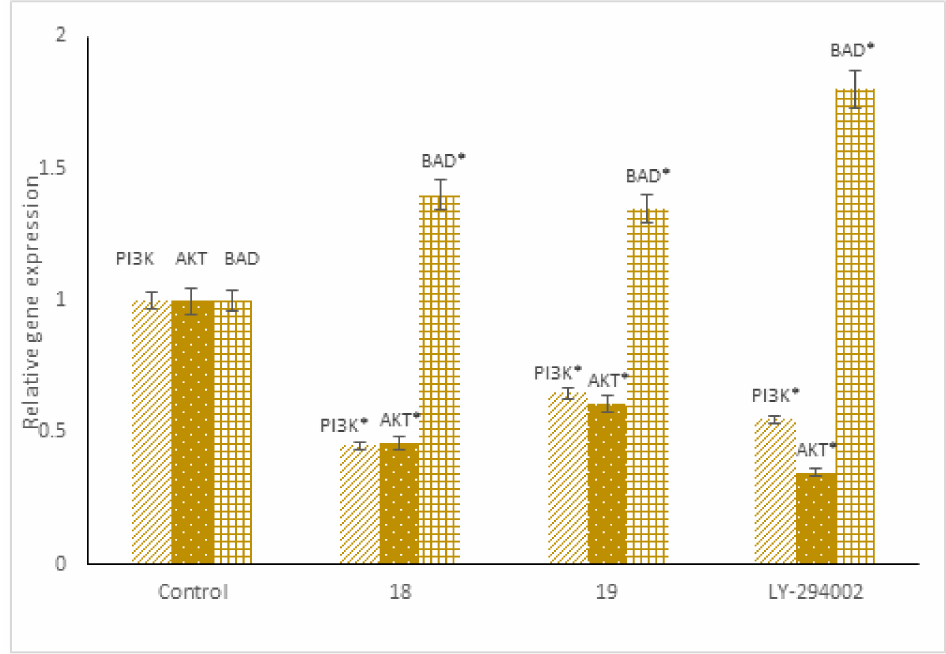
Figure 3. Relative gene expression of PI3K, AKT, and BAD in HCT116 cells after treatment with Compounds 18 and 19 and the positive control LY-294002. Bars represent mean values ± SEM (lines) of three replicates. Asterisks represent significant change relative to the negative control (* p <